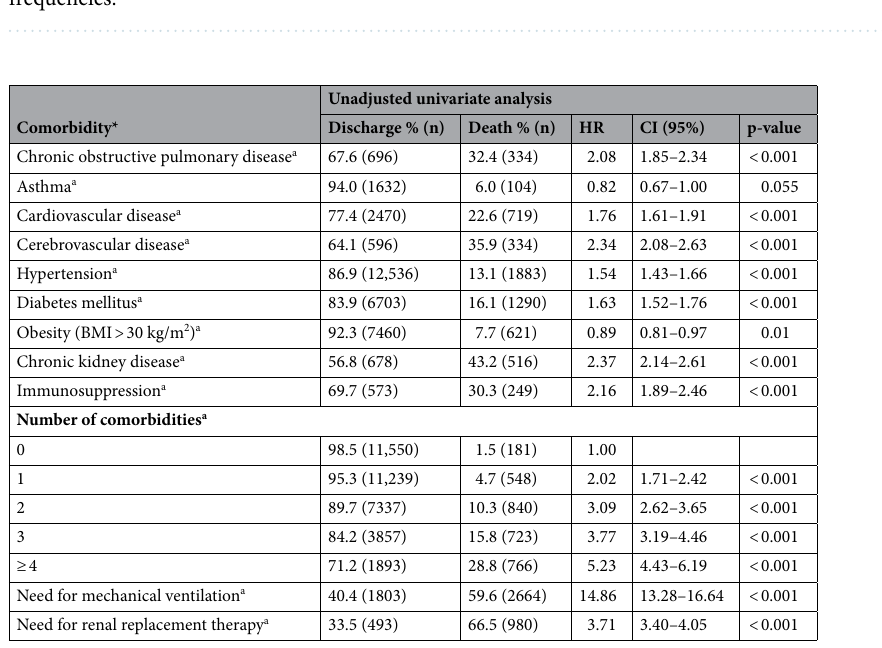
Table 2. Distribution of hospital discharges and deaths according to presence and number of comorbidities and the need for mechanical ventilation and renal replacement therapy in patients hospitalized due to coronavirus 2019 disease (from March 1st, 2020 to March 31st, 2021). Unadjusted analysis using the Cox regression model. HR Hazard ratio, BMI body mass index, CI confidence intervals. *Information obtained from the patient and/or accompanying members through the initial anamnesis questionnaire during hospital admission. a Values are expressed as relative and absolute frequencies.